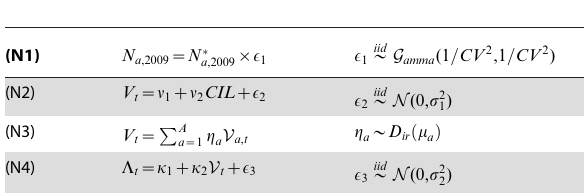
Table 5. Stochasticity in the input parameters for the SIMCAB projection model. The notation N (cid:2) abundance at age a in 2009 from data between 1984 and